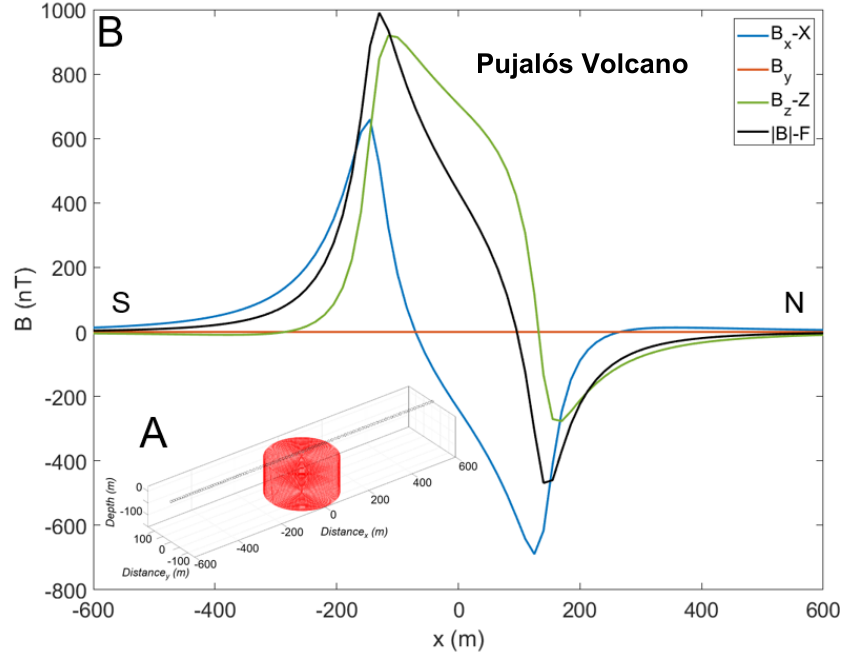
Figure 8. ( A ) Scheme of the simulated structure, a cylindrical body of 140 m radius at a depth of 150 m with respect to the surface, with a susceptibility of χ = 10 − 2 SI and a remanent magnetization of (Mx, My, Mz) = (1, 0, 1.5) Am − 1 using the geomagnetic reference system. ( B ) Results of the simulation.